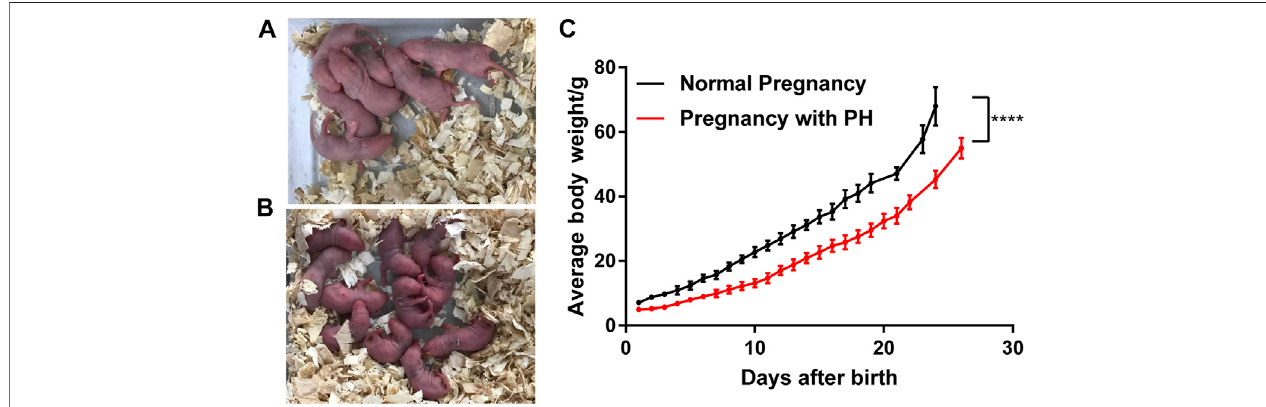
FIGURE4| Growth ofratoffspringinnormalpregnancyandthepregnancywithPHgroup. (A) Offspringinthenormalpregnancygrouponthethirddayafterbirth. (B) Offspring in the PH pregnancy group on the third day after birth. (C) The growth of average body weight (mean ± standard deviation) in each group was analyzed by paired Student ’ s t test. **** p < 0.0001 vs the normal pregnancy group ( n (cid:1) 6 rats per group). PH, pulmonary